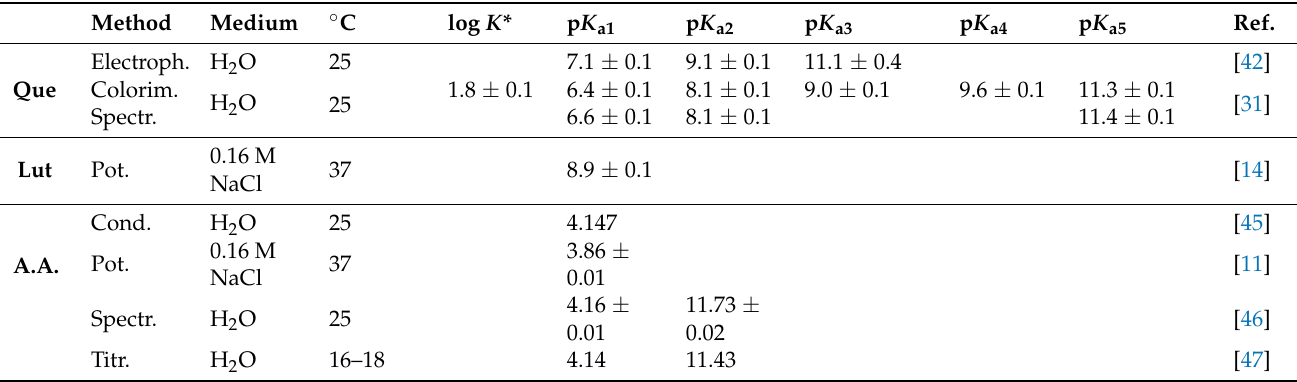
Table A1. Acidic constants of quercetin (Que), luteolin (Lut) and L -ascorbic acid (A.A.) from the literature. The uncertainties on the log values represent σ